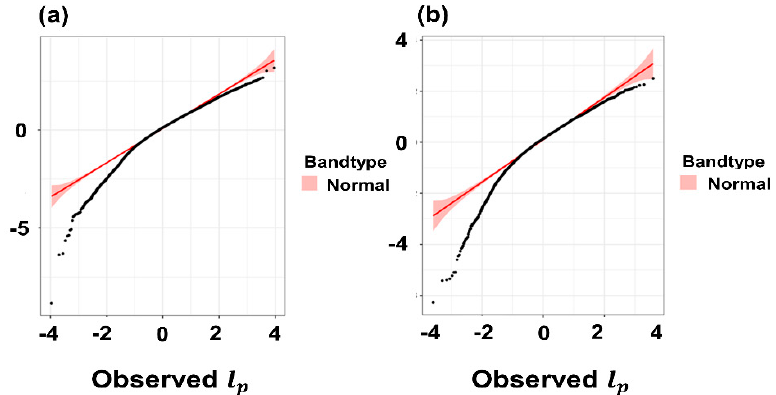
Figure 4. Normal-Quantile (QQ) plots of observed errors for ( a ) plant I and ( b ) plant II.